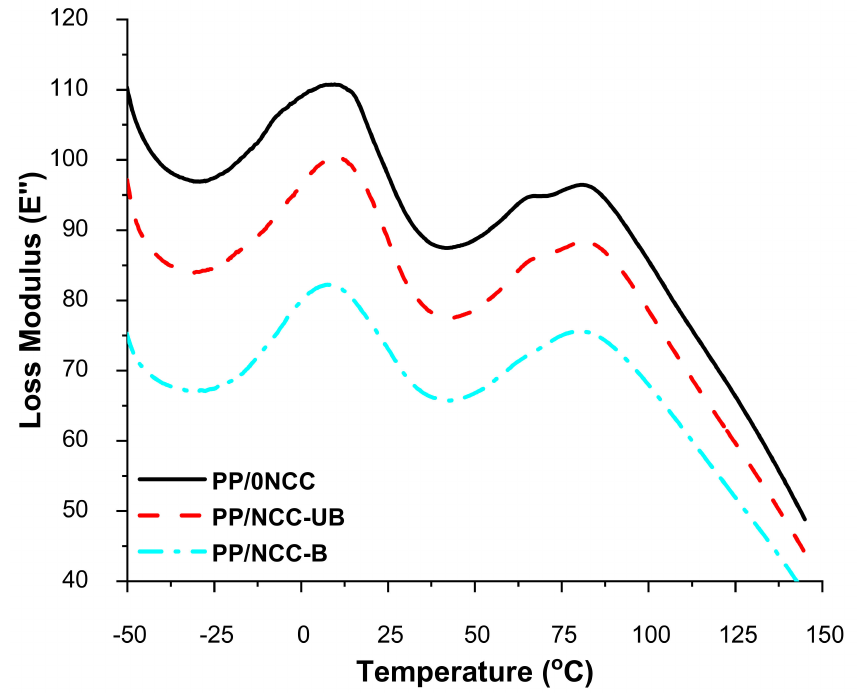
Figure 7. The loss modulus of kenaf core nanocomposites for reinforced bleached and unbleached